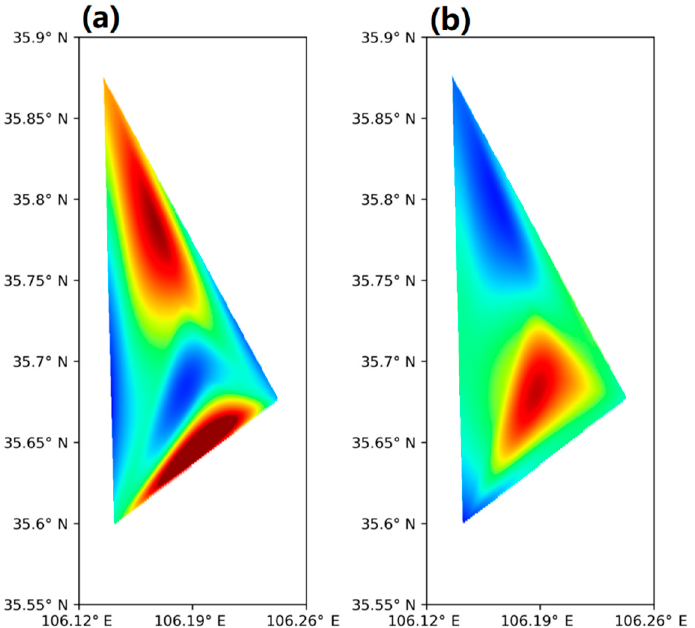
Figure 10. ( a ) The interpolation result of the experimental group in Liupan Mountain; ( b ) The interpolation result of the control group in Liupan Mountain.